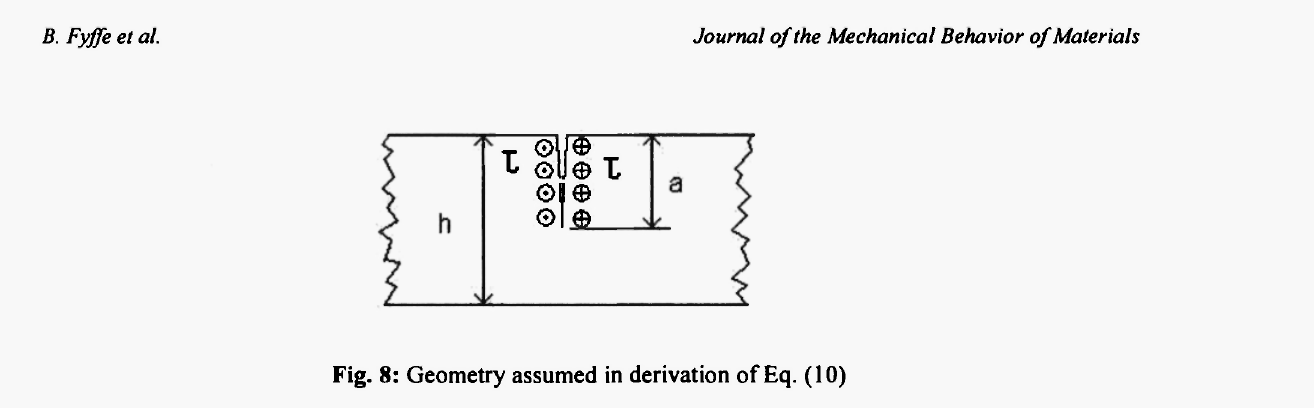
Fig. 8: Geometry assumed in derivation of Eq.